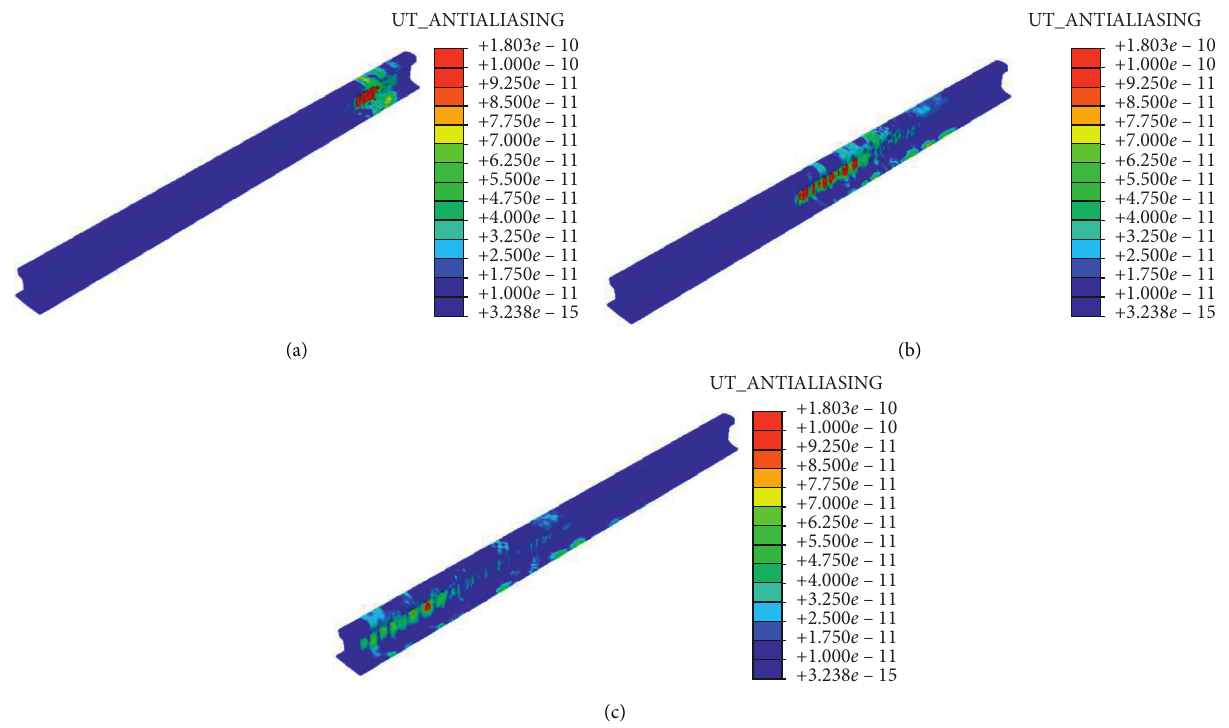
Figure 6: Wave propagation in a rail at time of (a) t � 0.01ms, (b) t � 0.4ms, and (c) t � 0.8ms.